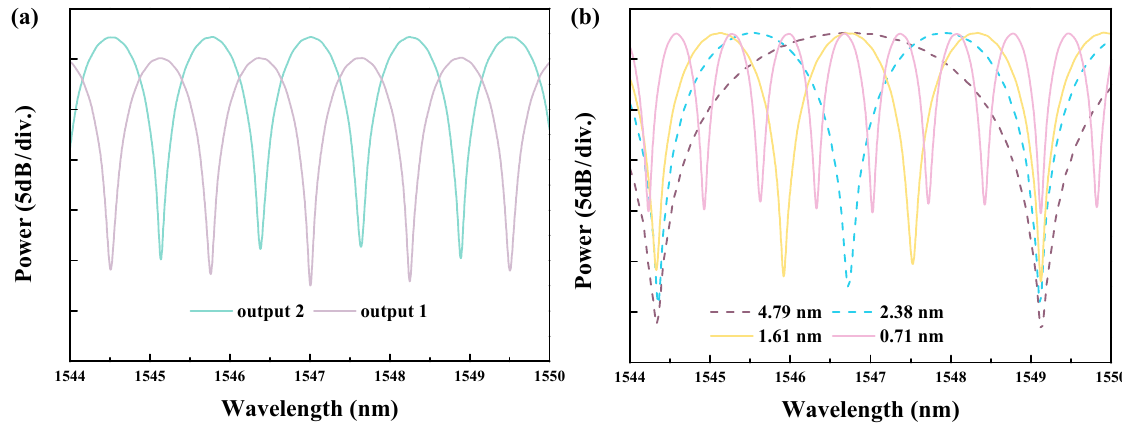
Figure 2. ( a ) The outputs of the TDI based on output 1 and output 2 ( b ) the TDI output for different FSR values using output 1.